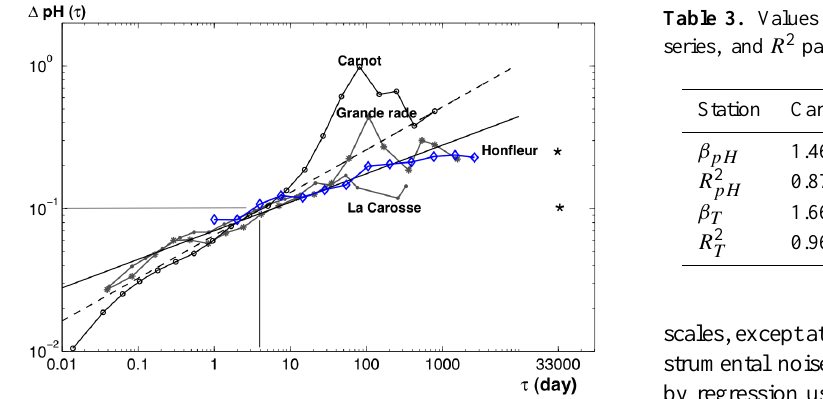
Fig. 6. First order structure function 1pH versus the time incre- ment τ : it shows how the mean fluctuations of pH depend on scale. This also indicates that local pH values may have huge variations. Dotted line: a power-law with slope 0.3; straight line: a power-law with slope 0.2. Stars: two points of coordinates (90yr, pH = 0 . 10 and 0.25) corresponding to a mean decrease of pH marine waters of 0.1 and 0.25 at the horizon 2100.